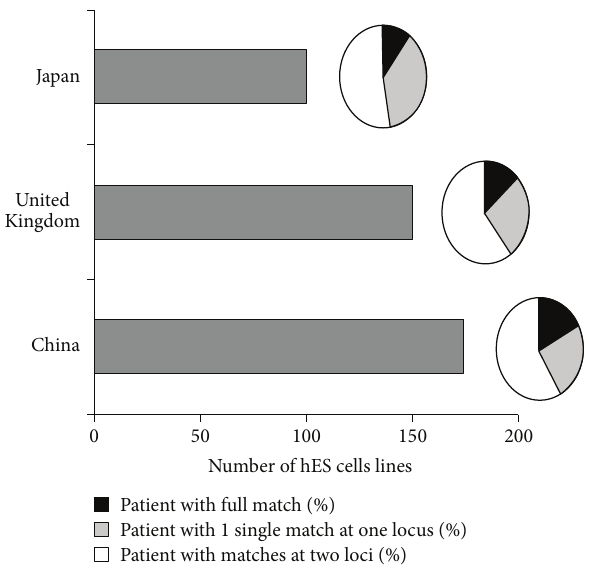
Figure 1: Hypothetical number of hPS cell lines haploidentical to a given population. Grey bars (left) represent the estimated number of homozygous hPS cell lines to achieve a full match (black; HLA- A, B and DR only) or two-match compatibility (white) with a given population (adapted from [23, 24,